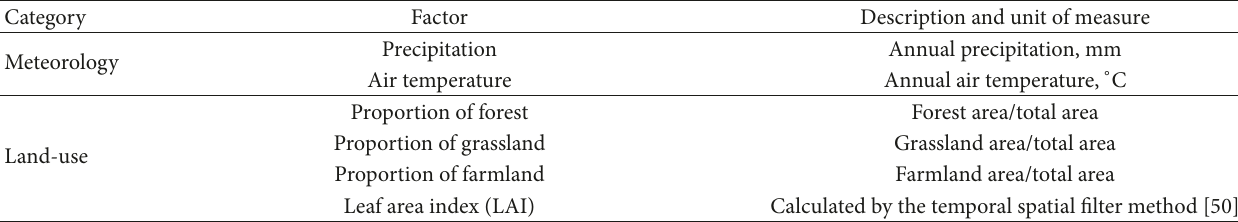
Table 1: Environmental factors used to analyze the decrease in